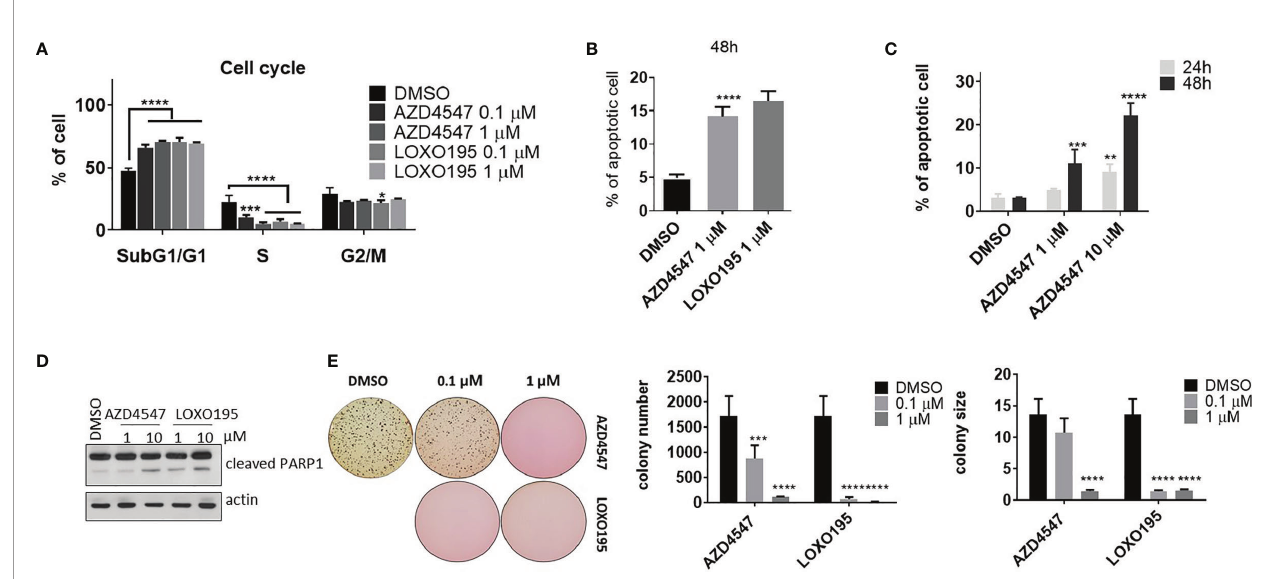
FIGURE 4 | Anti-tumor effect of AZD4547 on KM12(Luc) (TPM3-NTRK1). (A) AZD4547 induces SubG1/G1 arrest. KM12(Luc) cells were treated with the indicated substances for 24 h. After fi xation with 70% ethanol, cells were stained with PI containing RNase. Then, DNA contents of cells were analyzed by using fl ow cytometry. (average ± SD, n=3, two-way Anova; Dunnett ’ s multiple comparisons test; * < 0.05 *** < 0.001, ****p < 0.0001) (B) Apoptosis is induced by AZD4547 and LOXO195. (average ± SD, n=3 one-way Anova; ****p < 0.0001) (C) Time and dose dependent increases of apoptotic cells caused by AZD4547 treatment. (average ± SD, n=3 one-way Anova; ** <0.01, *** < 0.001 ****p < 0.0001) (D) Apoptotic marker, cleaved PAR-1 is up-regulated by AZD4547. (E) AZD4547 suppresses anchorage independent growth of KM12(Luc). (average ± SD, n=5 one-way Anova; *** < 0.001, ****p <